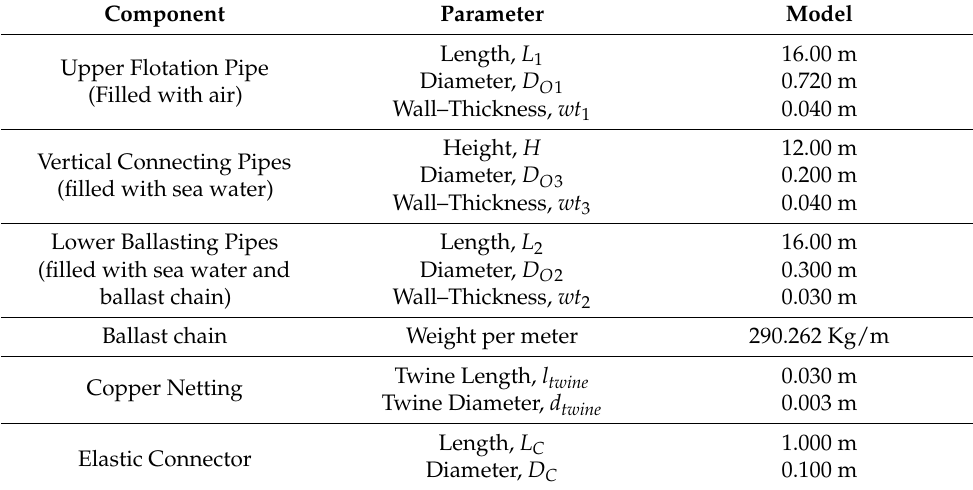
Table 1. Structure parameters of the fish